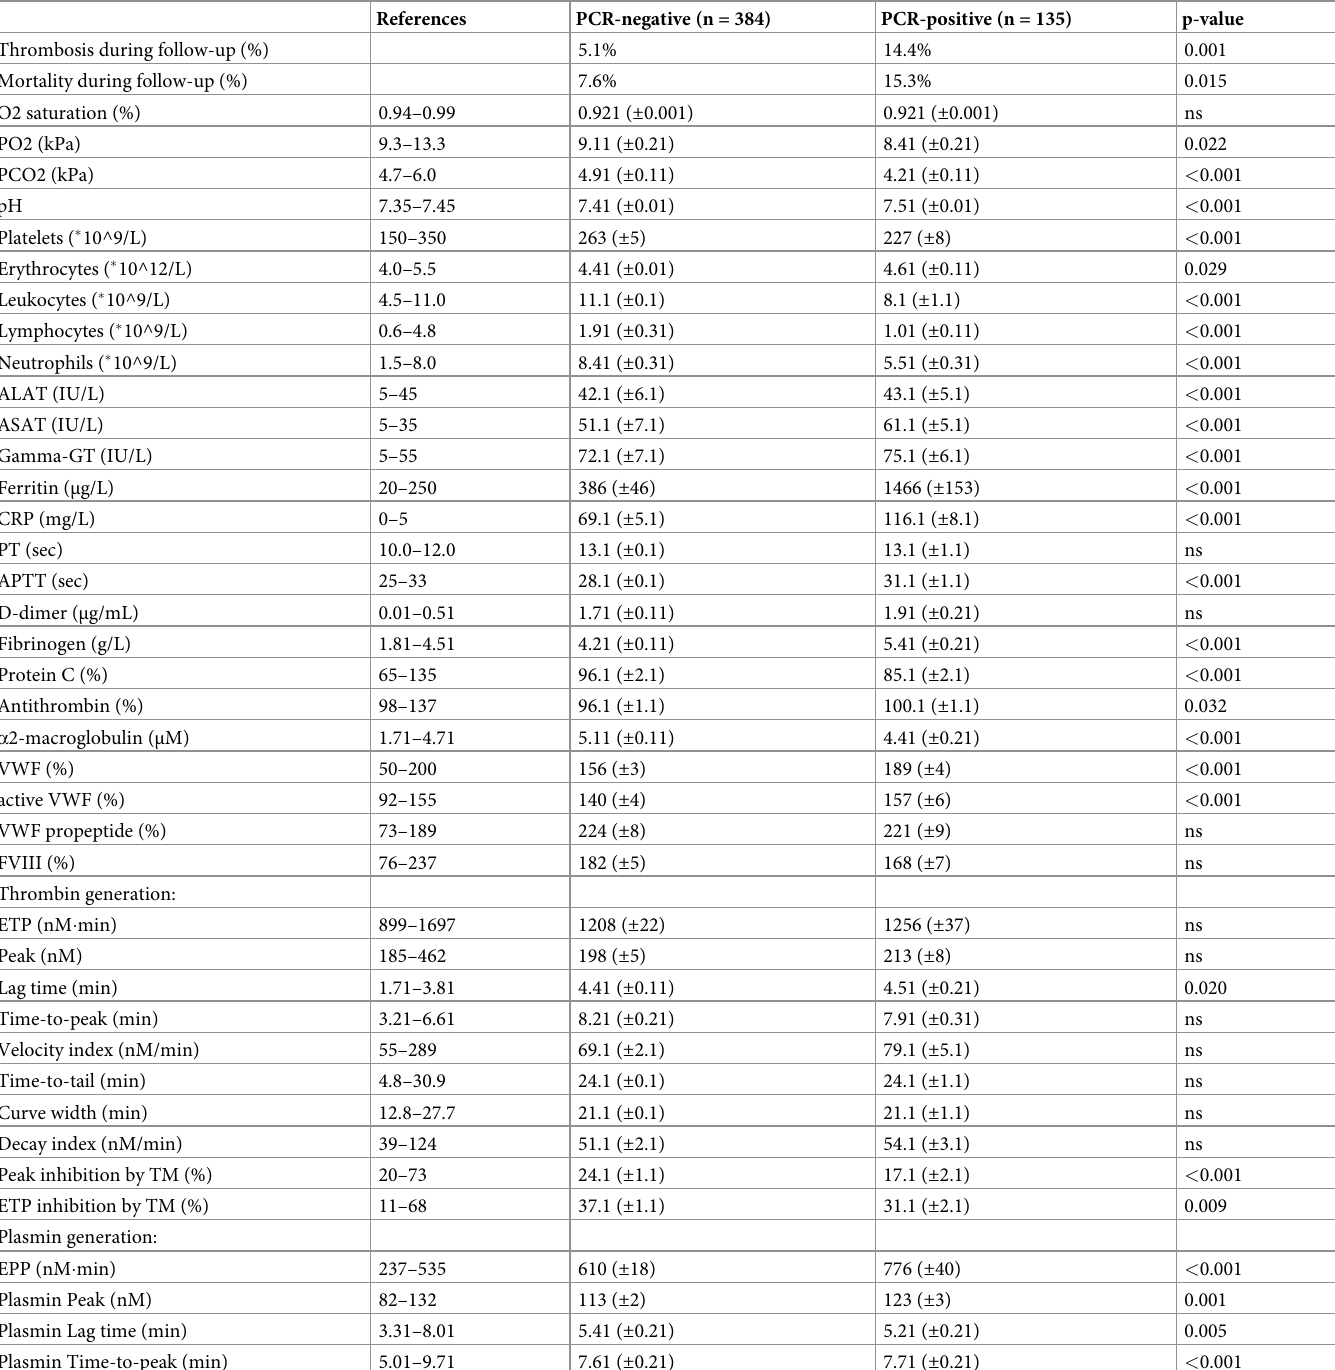
Table 2. General laboratory tests and specific coagulation test in PCR SARS-CoV-2 negative and positive